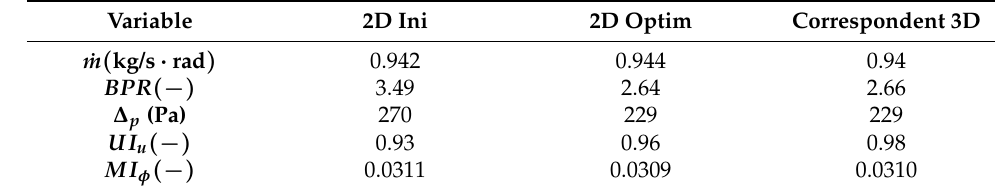
Table 5. Surface average results of the main variables.